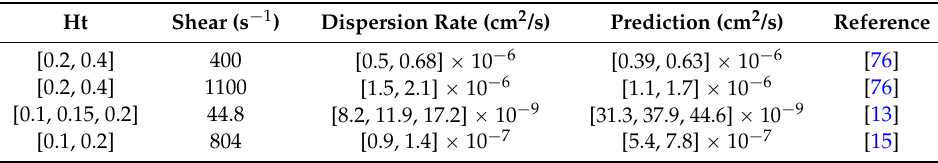
Table 2. Comparison of particle dispersion rate predictions from Equation (18) with dispersion rates reported in the